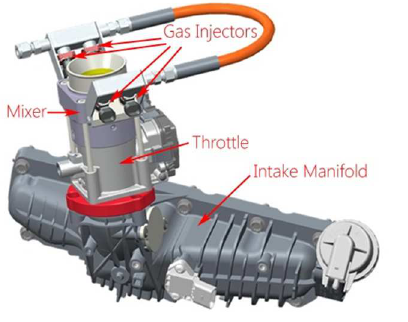
Fig. 2. CAD visualisation of gas mixer, throttle and intake manifold